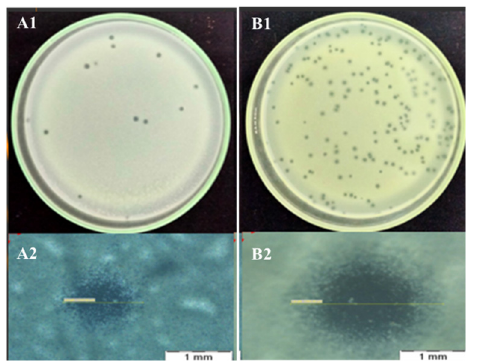
Figure 1. Plaques formed in double-layer agar plates: Φ K2 ( A1 ) and Φ K4 ( A2 ). Diameter of single plaques: Φ K2 ( B1 ) and Φ K4 ( B2 ). The bar corresponds to 1 mm. plaques: Φ K2 ( B1 ) and Φ K4 ( B2 ). The bar corresponds to 1 mm. Table 1. Plaque morphological characteristics of bacteriophages. Table 1. Plaque morphological characteristics of bacteriophages.